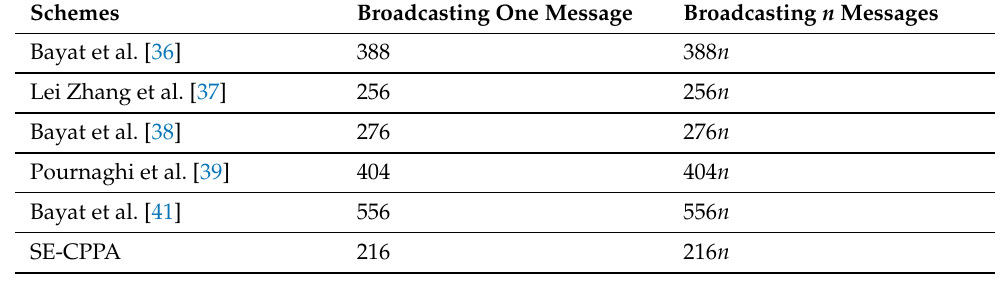
Table 7. Communication cost comparison.